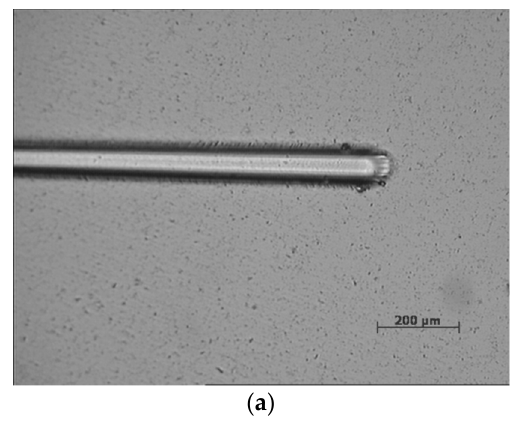
Figure 4. Optical micrographs of the scratch test: ( a ) coating deposited on steel substrates with 40 sccm of CH 4 , ( b ) coating deposited with 20 sccm of CH 4 .